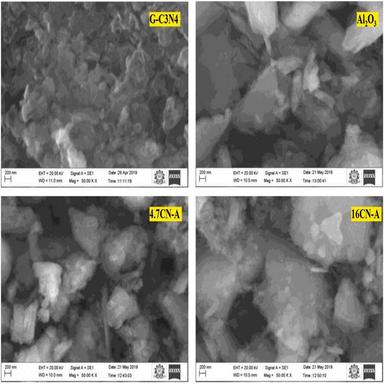
SEM-EDAX analysis of CN-A samples with various loadings: (a) g-C3N4; (b) Al2O3; (c) 16CN-A; (d) 4.7CN-A.